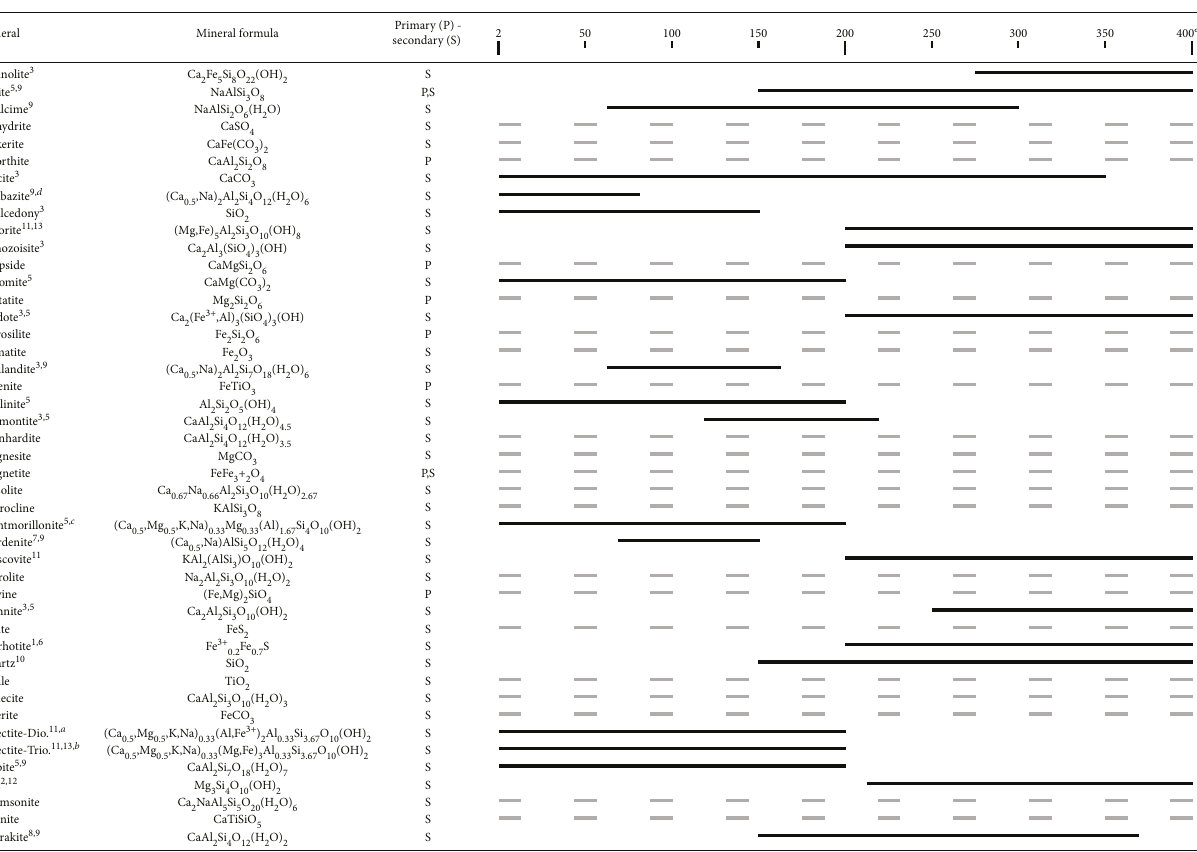
Figure 1: Temperature stability constraints for minerals occurring in hydrothermally altered mid-ocean ridge basalts. Full black lines: upper and/or lower stability constraints of the phase added in the code according to alteration mineralogy data after 1 Arnold et al. [39], 2 Lonsdale et al. [40], 3 Henley and Ellis [41], 4 Jenkins et al. [42], 5 Reyes [43], 6 Hannington et al. [44], 7 White and Hedenquist [45], 8 Jové and Hacker [46], 9 Chipera and Apps [47], 10 Bird and Spieler [48], 11 Monecke et al. [49], 12 Hodgkinson et al. [50], and 13 Thien et al. [51]. Dashed grey lines: nonconstrained mineral phase. Ideal solid solution endmembers: a Ca-beidellite, Ca-nontronite, Mg-beidellite, Mg-nontronite, K-beidellite, K-nontronite, Na-beidellite, and Na-nontronite; b Ca-saponite, Fe-saponite, Mg-saponite, K-saponite, and Na-saponite; c Ca- montmorillonite, Mg-montmorillonite, K-montmorillonite, and Na-montmorillonite; and d Ca-chabazite and